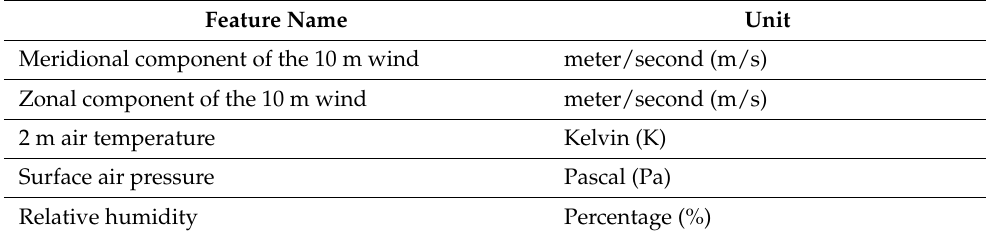
Table 1. Surface meteorology features and their units.